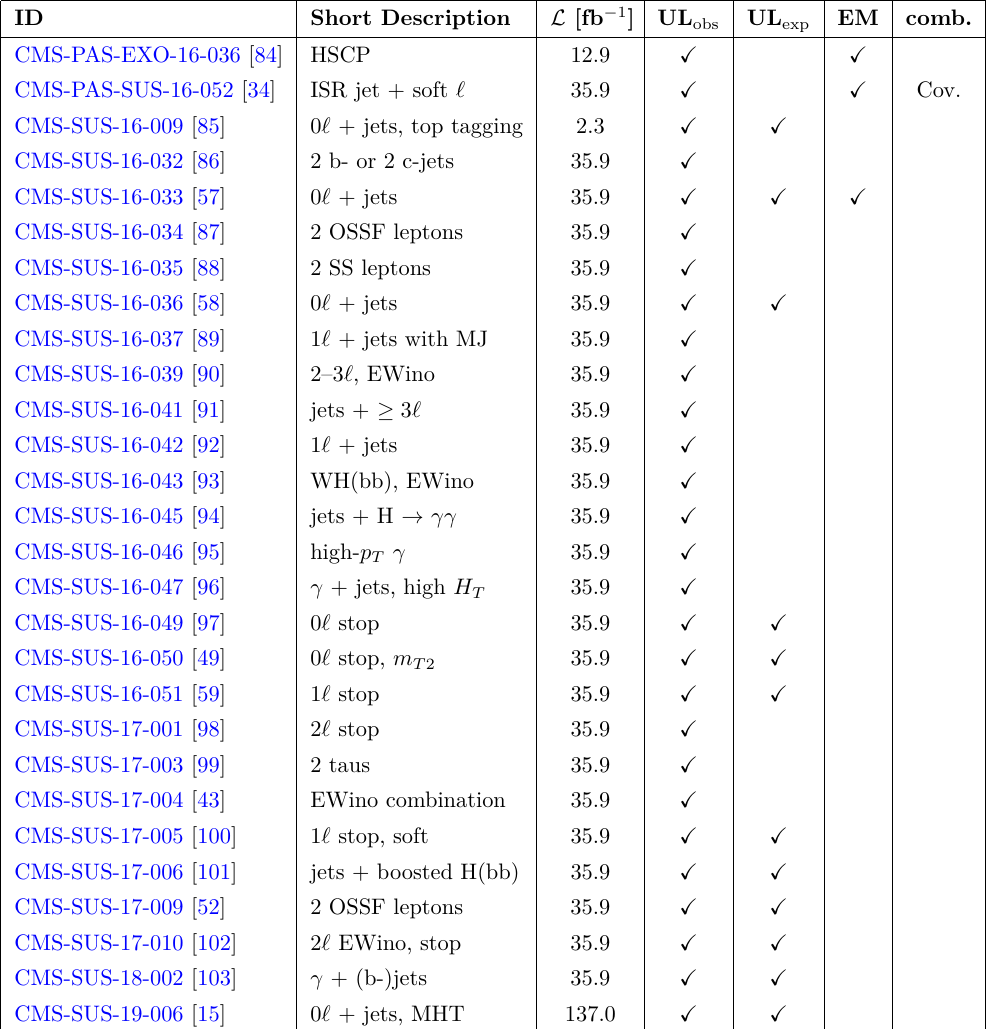
Table 6 . List of CMS Run 2 analyses and their types of results in the SModelS v1.2.4 database. In the last column, “Cov.” stands for covariance